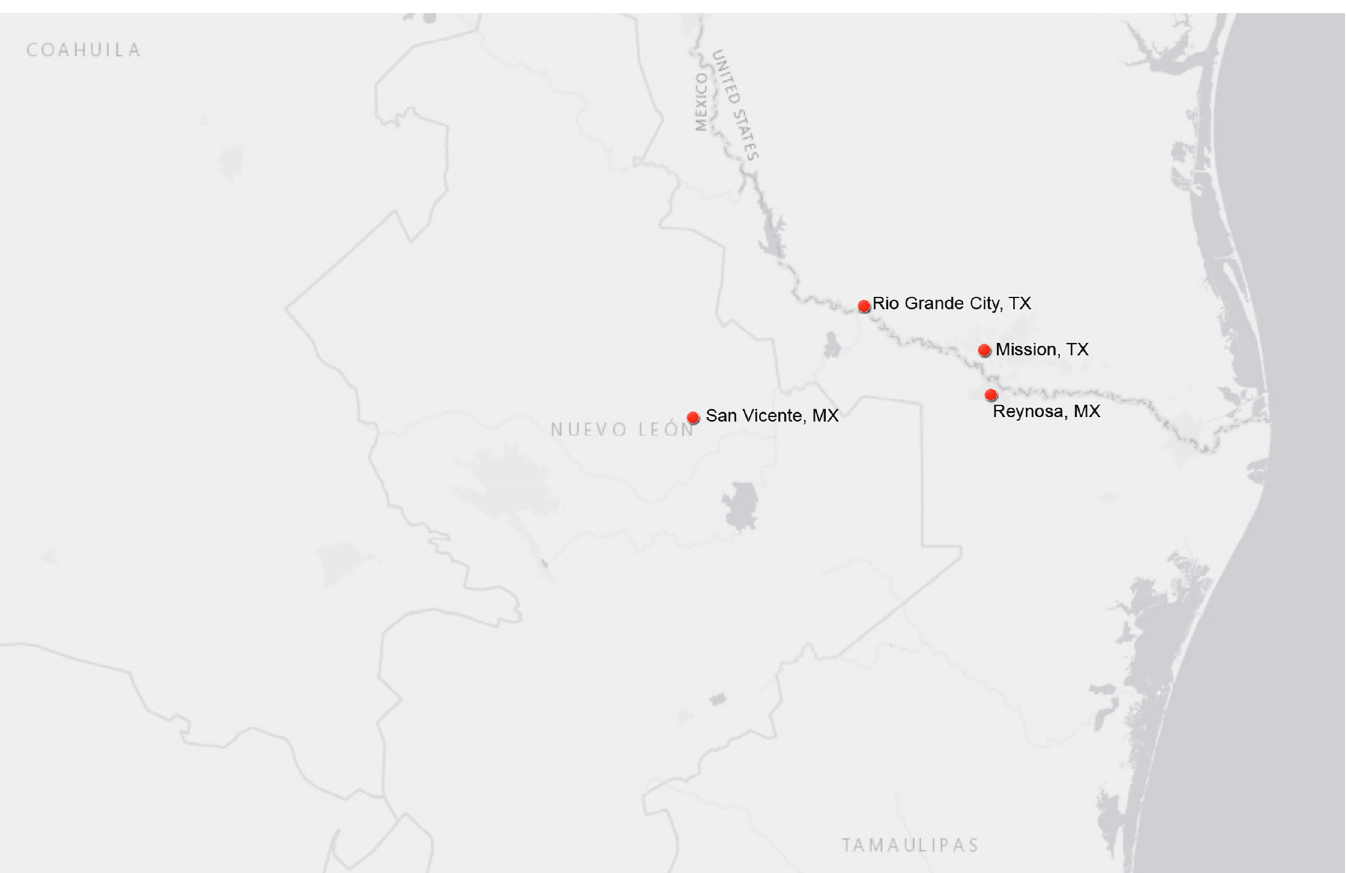
Fig 1. Location of study site and important locations of Chagas positive participants. This figure was generated in ArcGIS. The authors purchased the software license and own rights to the figure. Additionally, this figure was approved for publication using PACE.